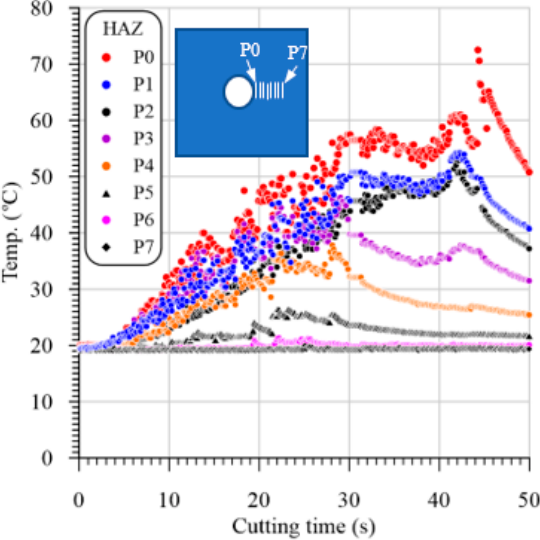
Figure 4. Temperature obtained by IR camera vs. cutting time in drilling GFRP with 5.3 mm thickness at 400 rpm and 0.025 mm/r at different positions using 118 ◦ drill point angle.